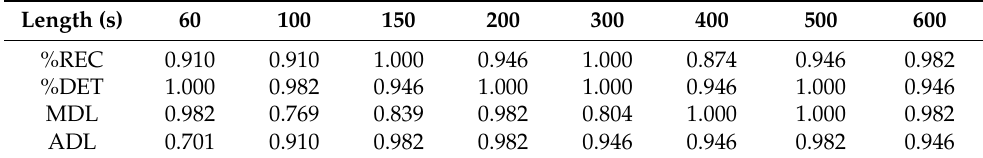
Table 3. Mann–Whitney U test results for comparing measures of RQA at 750 s with shorter data lengths. No significant differences show in any length